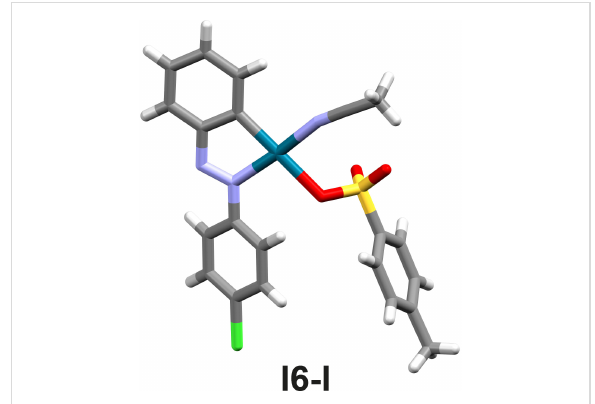
Figure 4: Experimental X-ray molecular structure of the intermediate I6-I .